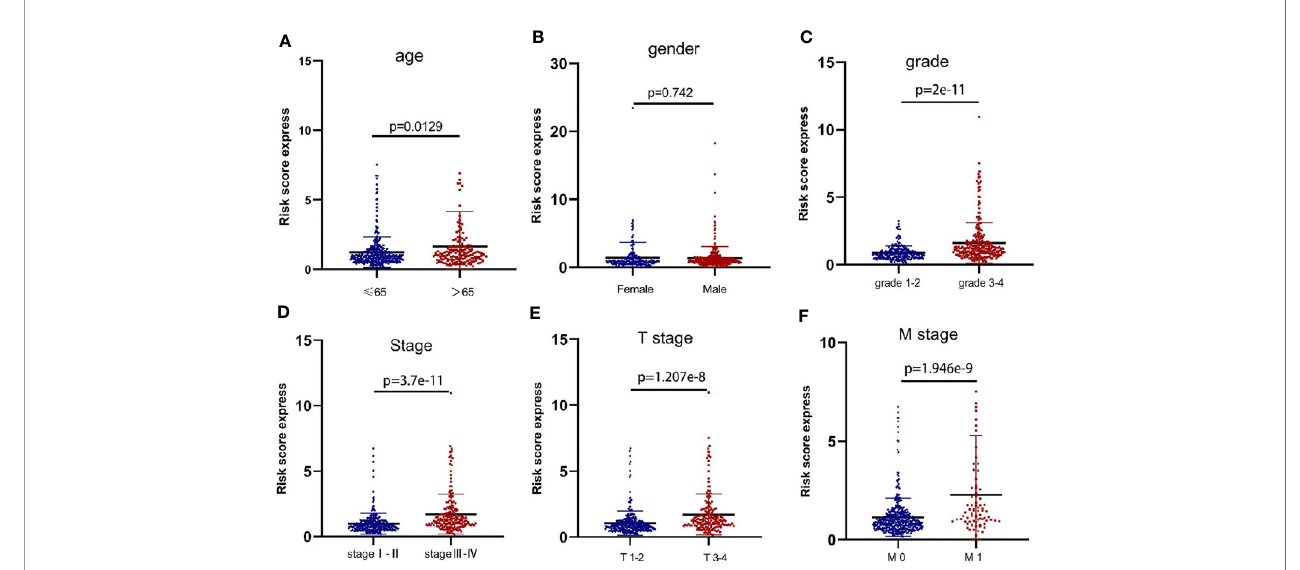
FIGURE 3 | The metastasis-related lncRNA signature was associated with ccRCC progression. The correlation between the signature risk scores and the clinicopathological features, such as (A) age (<=65 vs >65, p=0.0129), (B) gender (Female vs Male, p=0.742), (C) grade (grade 1-2 vs grade 3-4, p=2e-11),